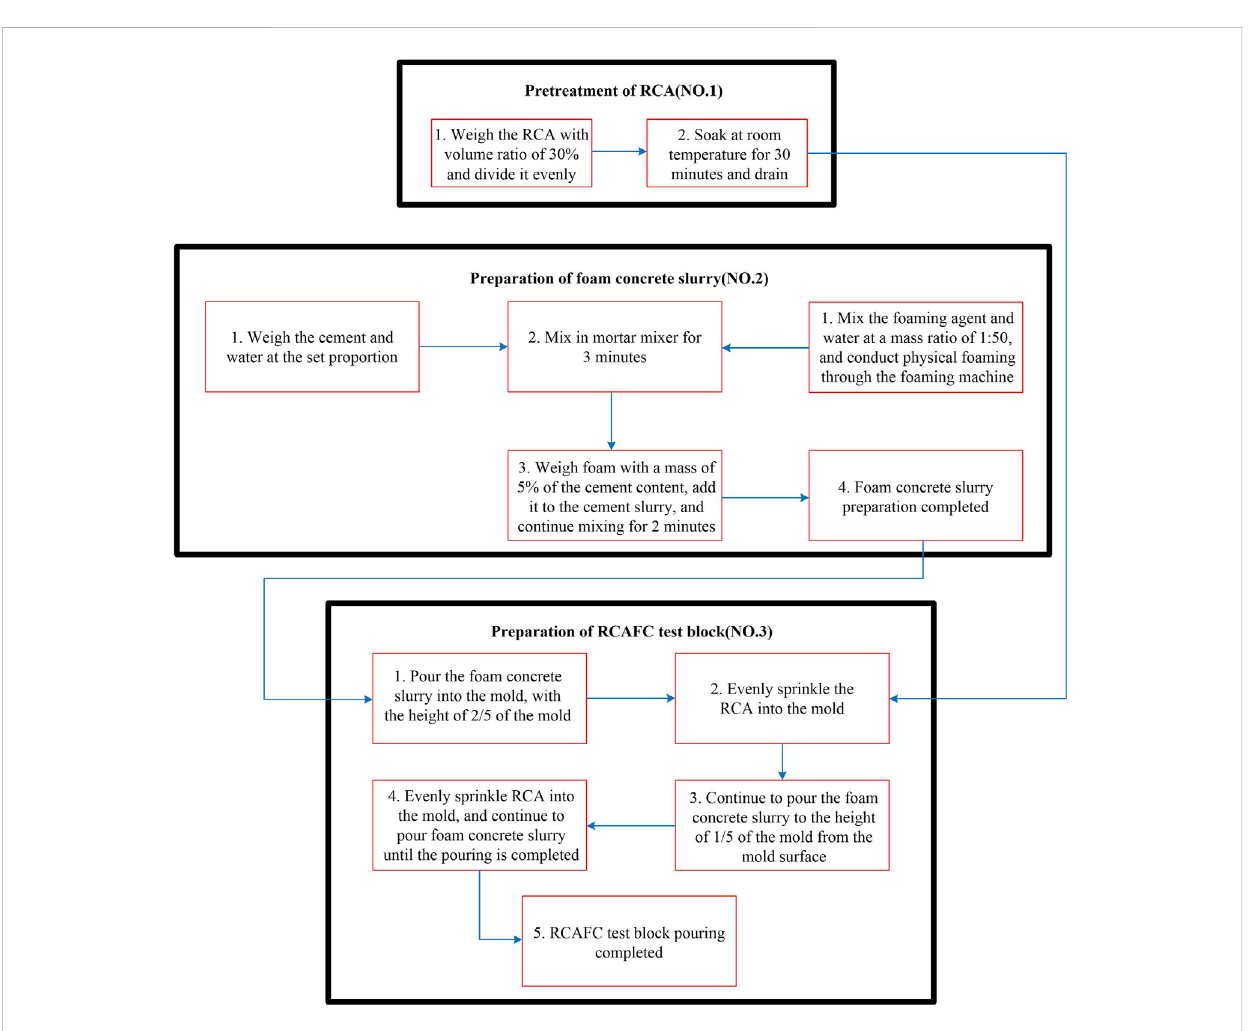
FIGURE 2 Preparation fl owchart of